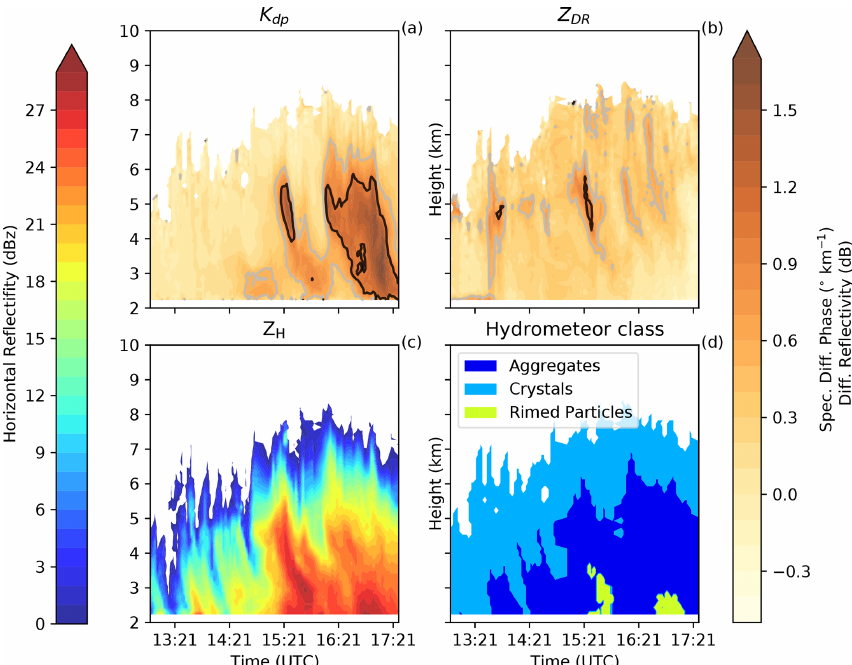
Figure 3. Hovmöller diagrams of the (a) spectral differential phase ( K dp ), the (b) differential reflectivity ( Z DR ), (c) the horizontal reflectivity ( Z H ) and (d) the hydrometeor class categories derived from the Doppler radar between 13:00 and 17:30UTC. The gray and black lines in panels (a) and (b) are where both K dp and Z DR are larger than 0.5 and 1,